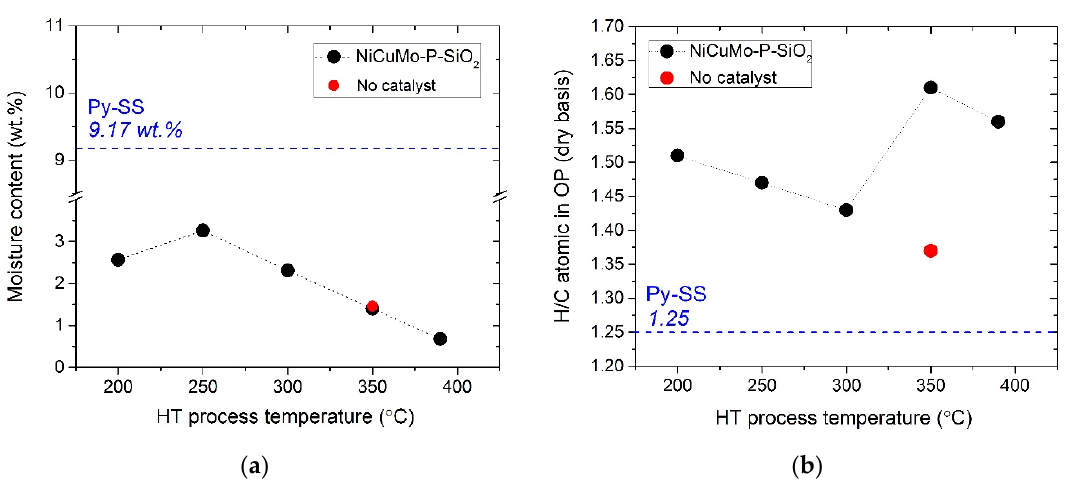
Figure 3. ( a ) Moisture content, wt. %; ( b ) H / C atomic rations on a dry basis of Py-SS and organic-rich phases (OP) obtained after catalytic and non-catalytic hydrotreatment of Py-SS.